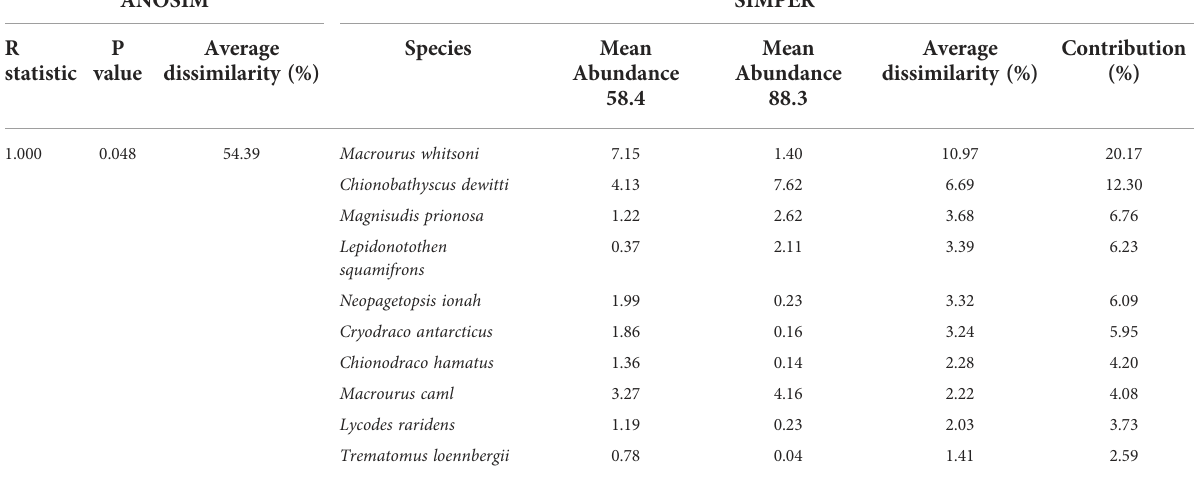
TABLE 4 Results of the analysis of similarities (ANOSIM) and similarity percentages (SIMPER) analysis of the abundance of discriminating prey items in subareas 88.3 and 58.4.